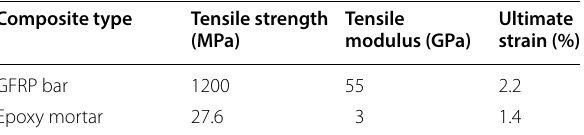
Table 2 Properties of the NSM GFRP bars and epoxy material.